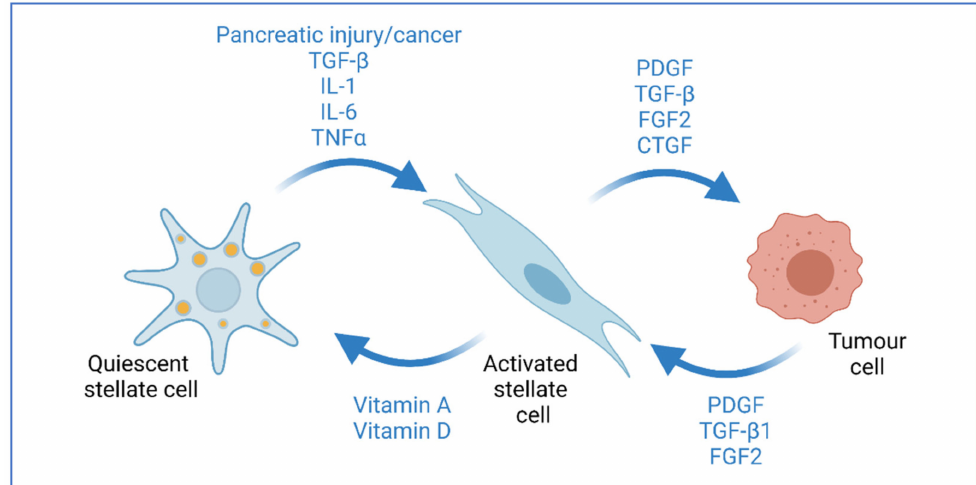
Figure 2. Interaction of stellate cells and cancer cells. Pancreatic stellate cells become activated in response to tissue injury and inflammation. This activation causes the cells to lose their vitamin-filled lipid droplets and express myofibroblast markers. Activated stellate cells in tumours can promote tumour cell proliferation through growth factor secretions, such as FGF2. Tumour cells can also promote stellate cell activation through growth factors, such as TGF- β . Activated stellate cells can be returned to their quiescent state through treatment with All-trans retinoic acid or vitamin D derivatives [7]. Created with